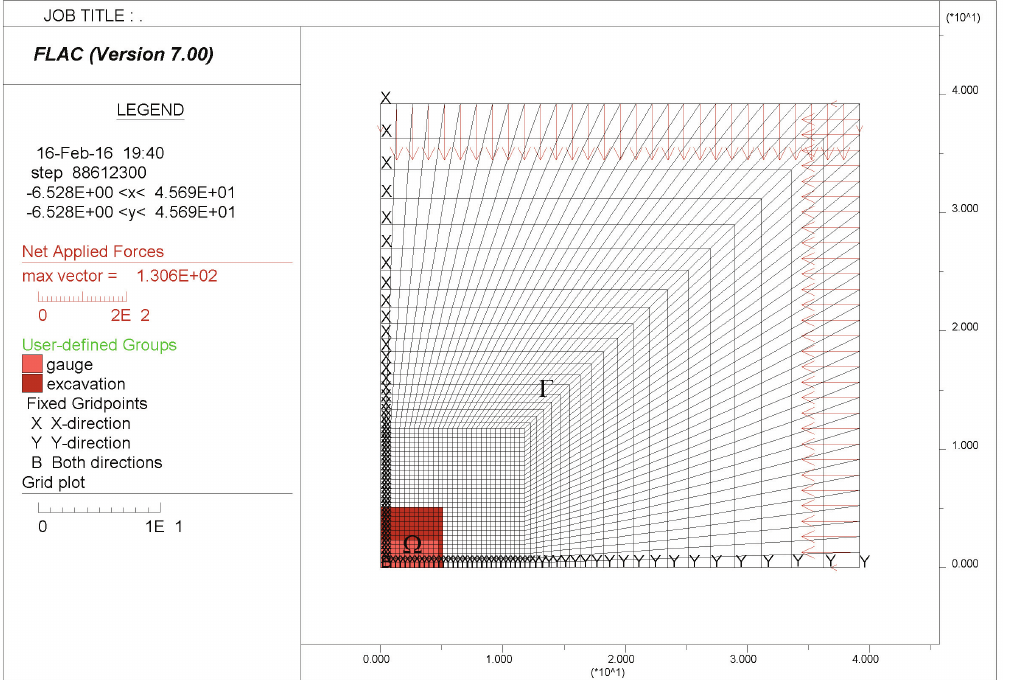
Fig. 1. A boundary value problem under